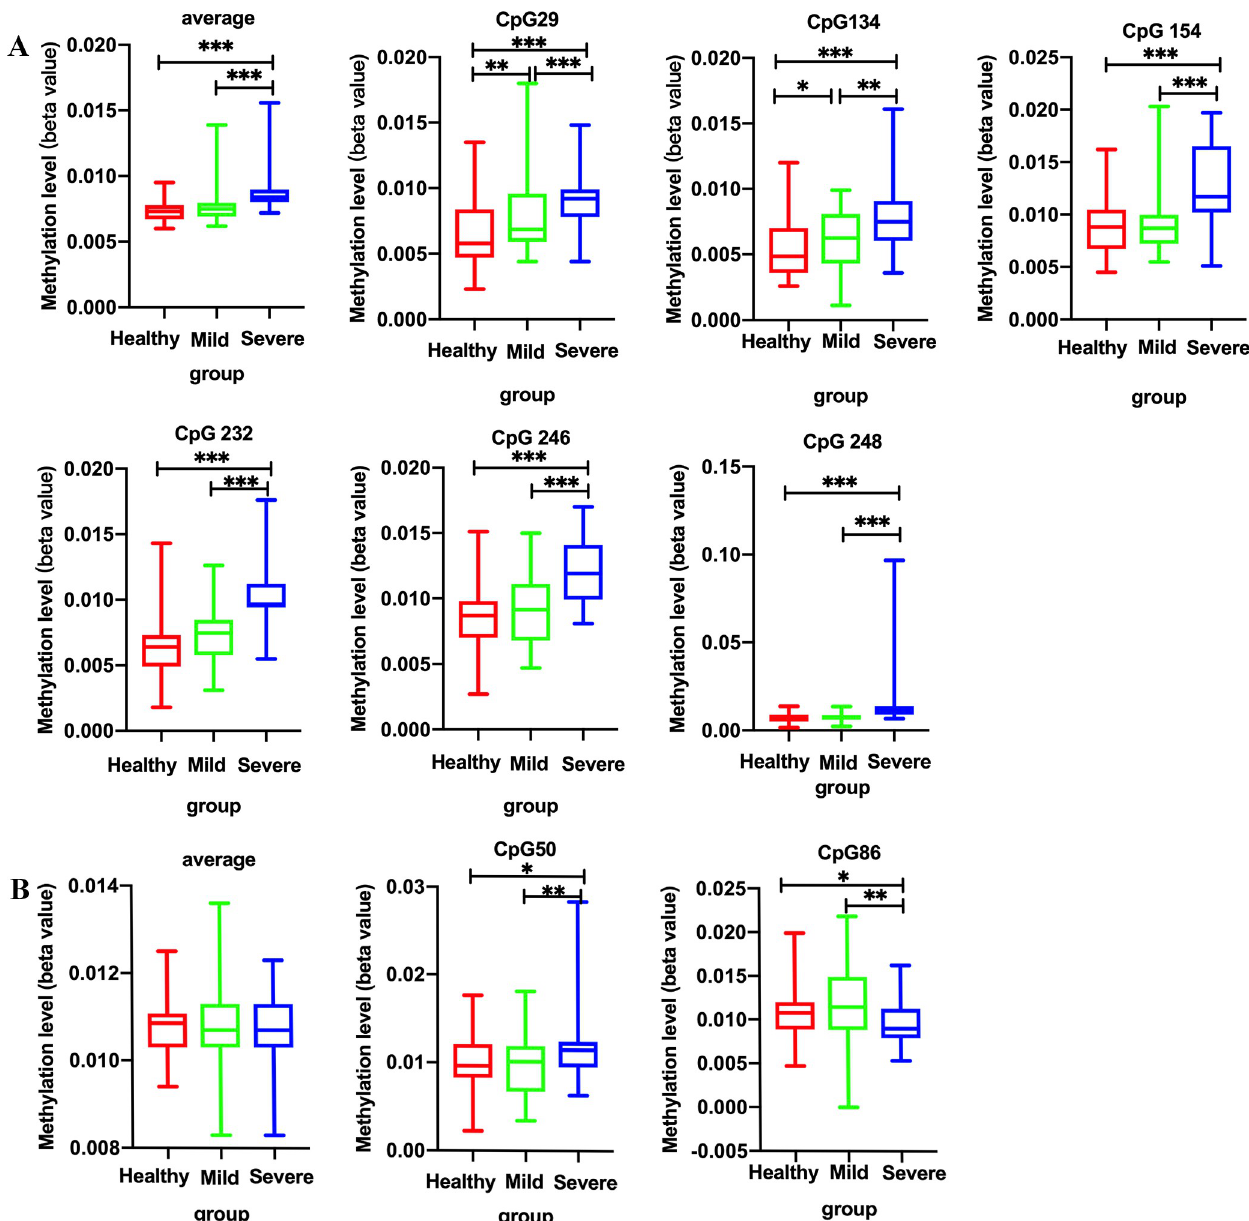
Fig 2. DDX58 methylation levels of each positive CpG site (the 29, 134, 154, 232, 246 and 248 CpG sites) in all samples, including healthy subjects and EV71-HFMD patients (A). IFIH1 methylation levels of each positive CpG site (the 50 and 86 CpG sites) in all samples, including those of healthy subjects and EV71-HFMD patients. (B) � p < 0.05, �� p < 0.01, ��� p < 0.001.